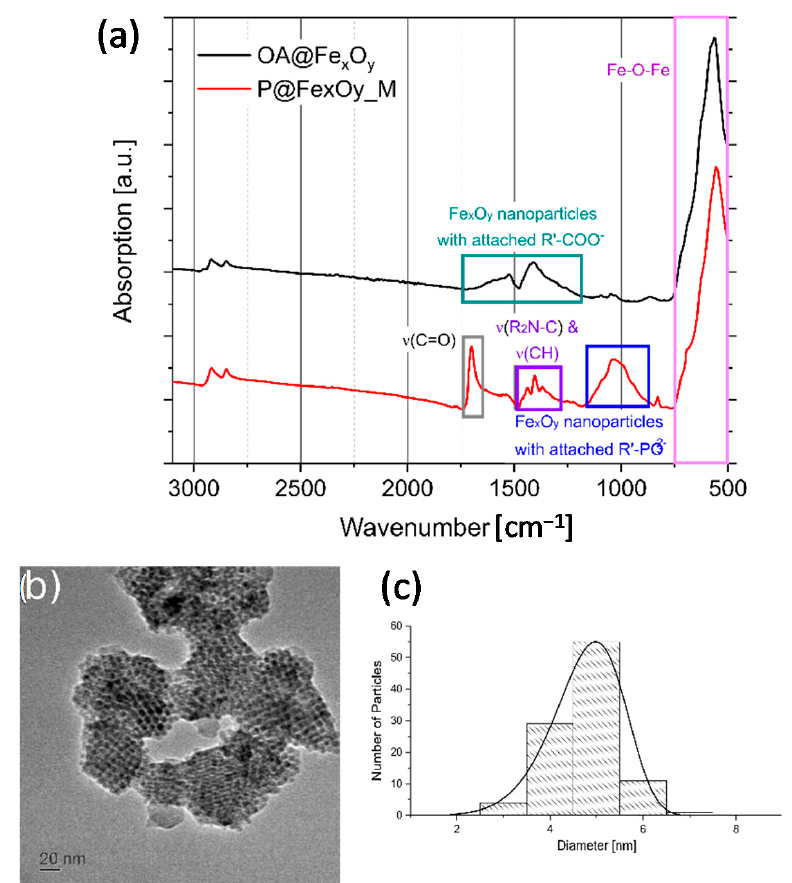
Figure 4. Maleimide-functionalized iron oxide nanoparticles: ( a ) FTIR spectra, ( b ) TEM image, and ( c ) size distribution histograms obtained from 100 particles.